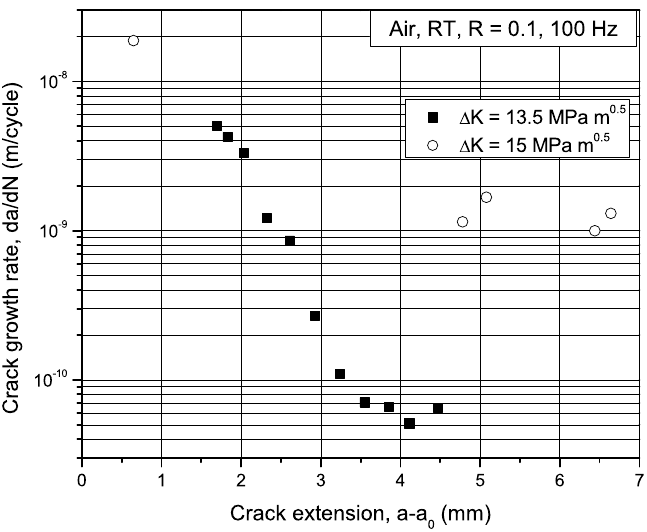
Figure 5. Results of fatigue crack growth tests conducted at constant Δ K and increasing crack extension from the initial Electro Discharge Machined (EDM) crack starter